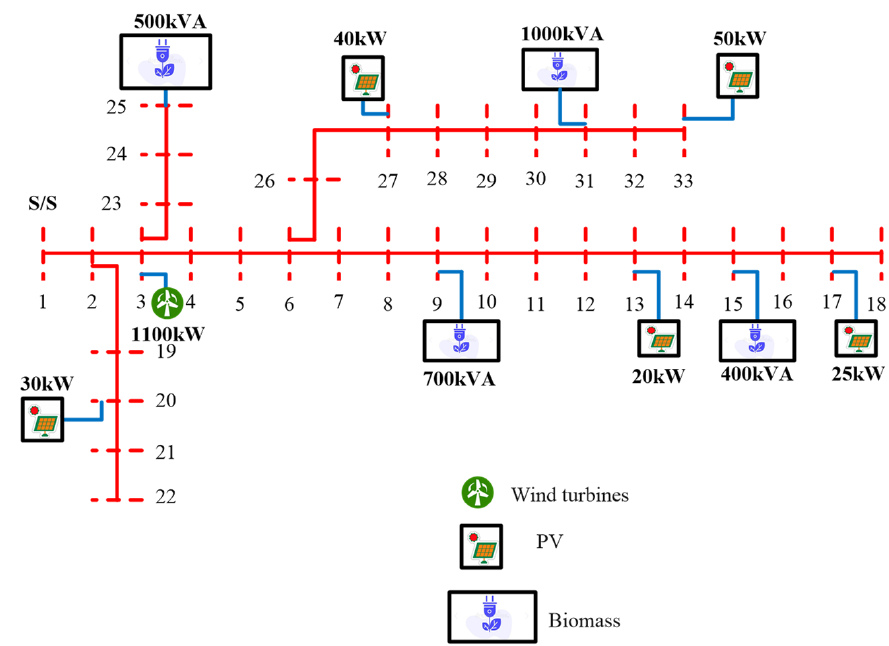
Figure 4. First MG configuration .